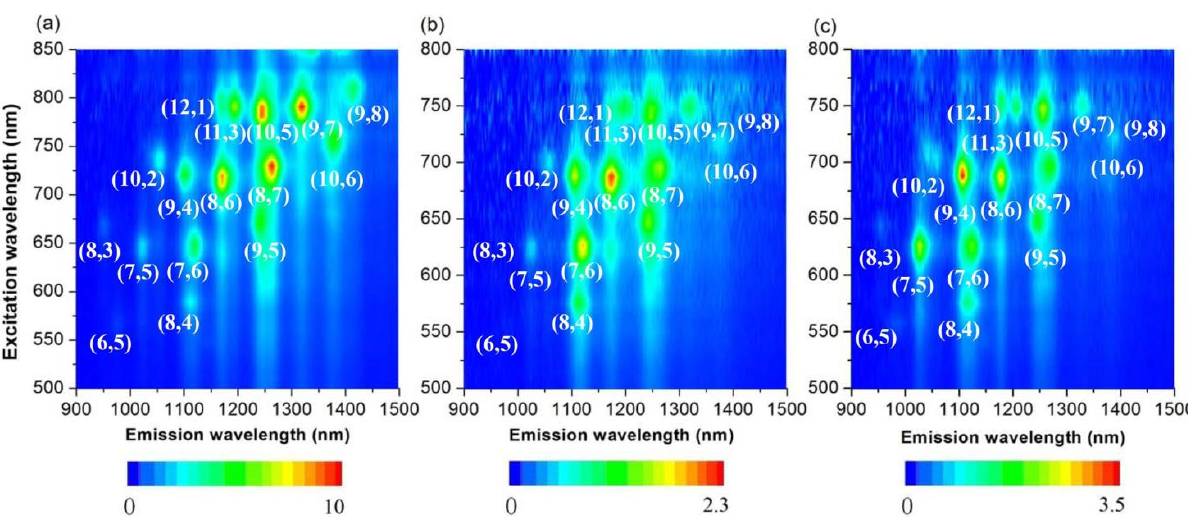
O/SDBS solutions of HiPCO before ( a ); and 2